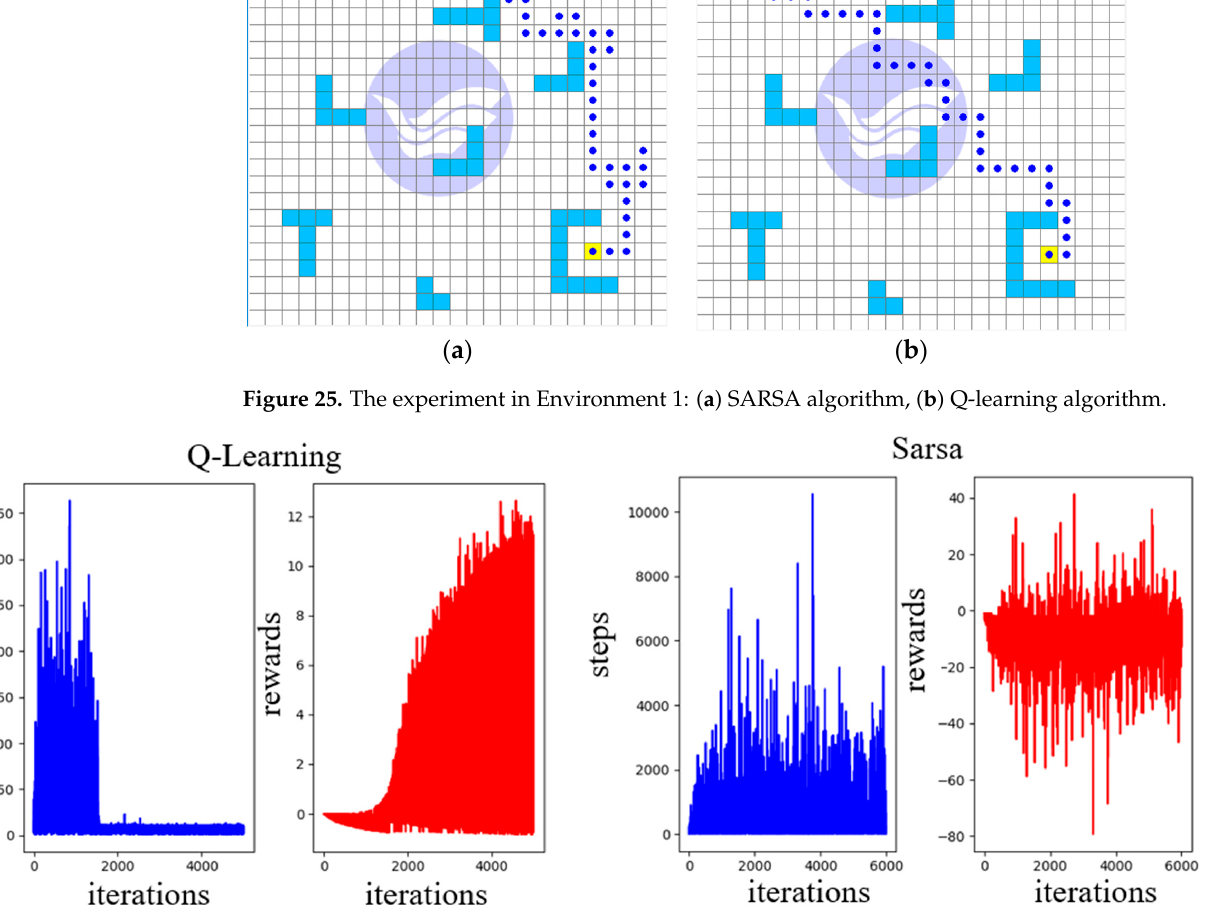
Figure 26. Training results of Q-Learning and SARSA in Environment 1, ( a ) is Q-Learning training result, ( b ) is SARSA training result. Table 2. The results compared for Environment